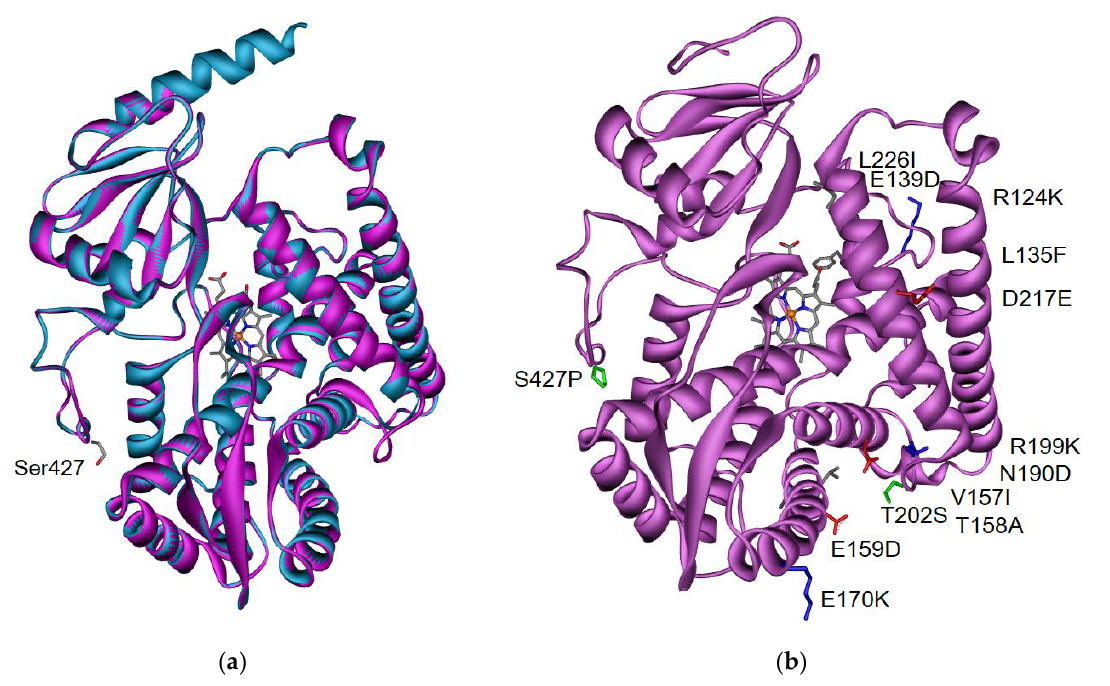
Figure 2. ( a ) Sequence and structure comparison between native rCYP4B1 (cyan) and the homology model of native hCYP4B1 (mauve): Location of S427 of hCYP4B1 is highlighted ( b ) Homology model of engineered h-P+12: Nonidentical amino acids compared to native hCYP4B1 are depicted (green: hydrophilic, grey: hydrophobic, red: negatively charged, blue: positively charged). Please note that the engineered h-P+12 does not contain parts of the original N-terminus (first α